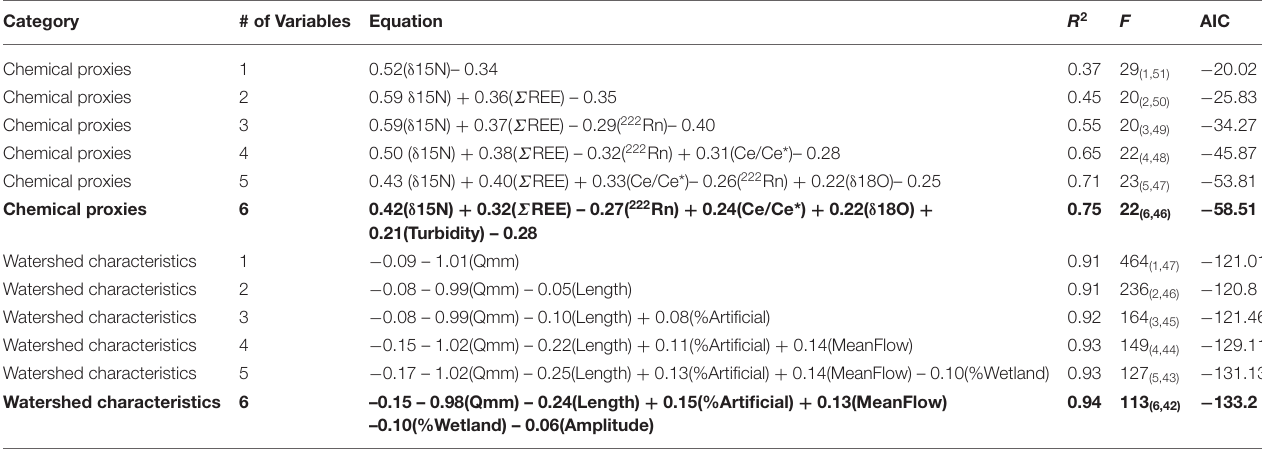
TABLE 2 | Multiple linear regression models for N attenuation using chemical proxies and watershed characteristics.